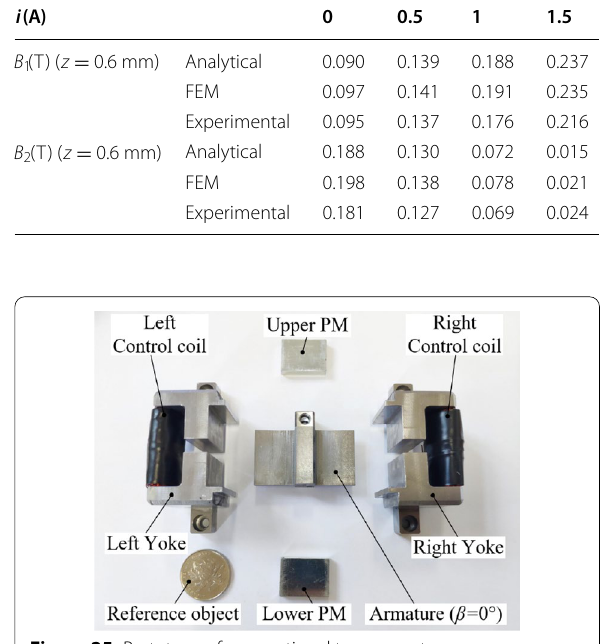
Figure 25 Prototype of conventional torque motor